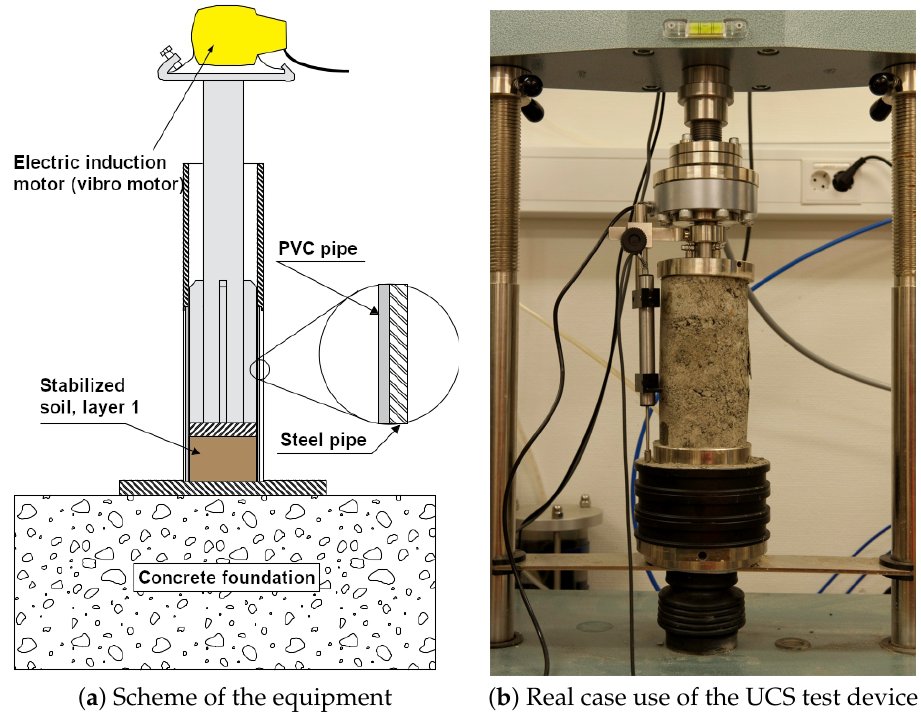
Figure 2. Compaction equipment for soil stabilisation ( a ); Specimen that reached failure ( b